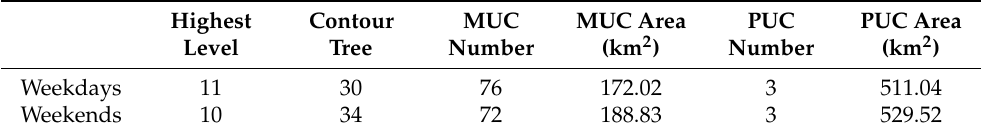
Table 4. Basic information on urban centers on weekdays and